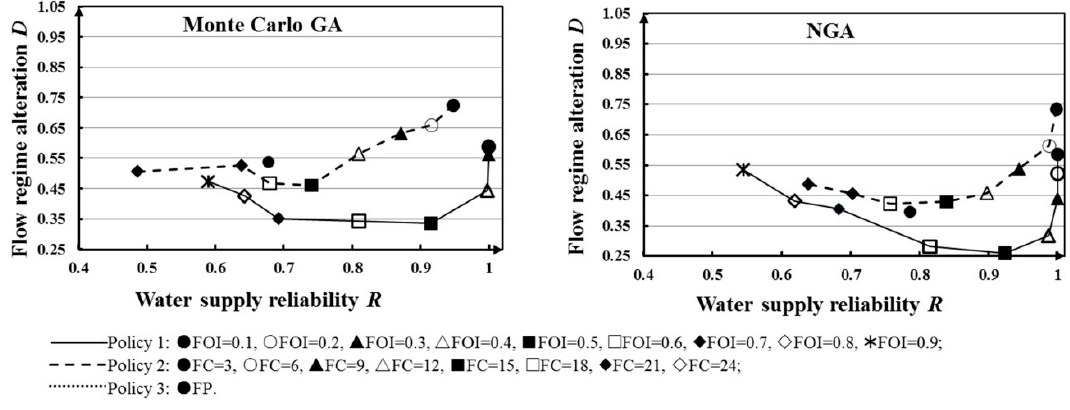
Figure 13. Illustration of the tradeoff between the total flow regime alteration R and water supply reliability, D, based on Monte Carlo GA and NGA.